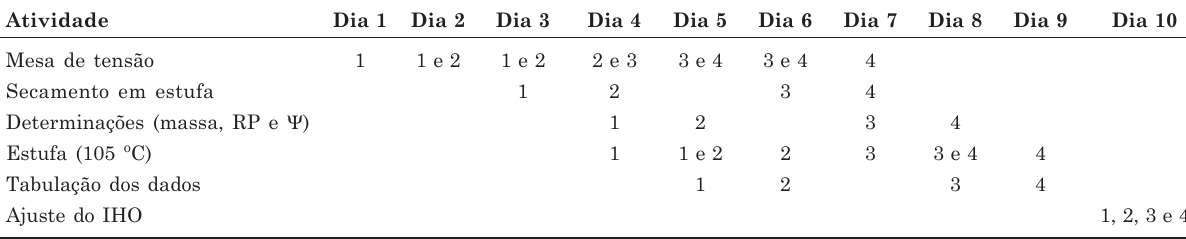
Quadro 1. Cronograma de atividades para obtenção dos